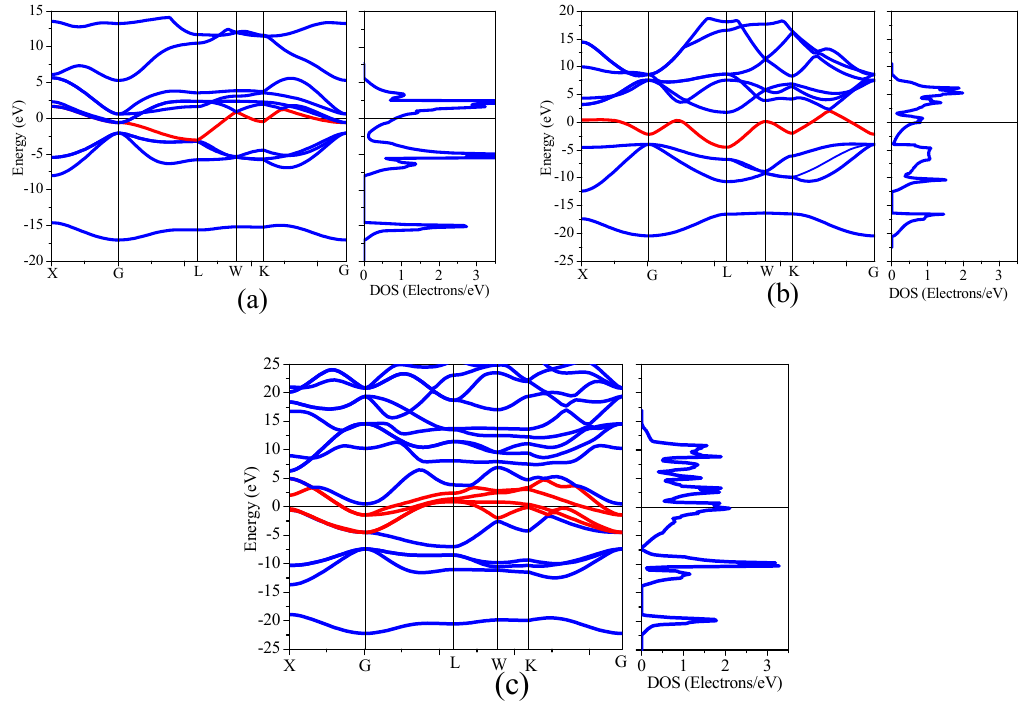
Figure 5. Band structure and density of state (DOS) of B1–NaCl structure of ( a ) TiN, ( b ) the B1–NaCl structure interface of SiN, ( c ) and the interstitial interface of 1Si–4N4Ti.